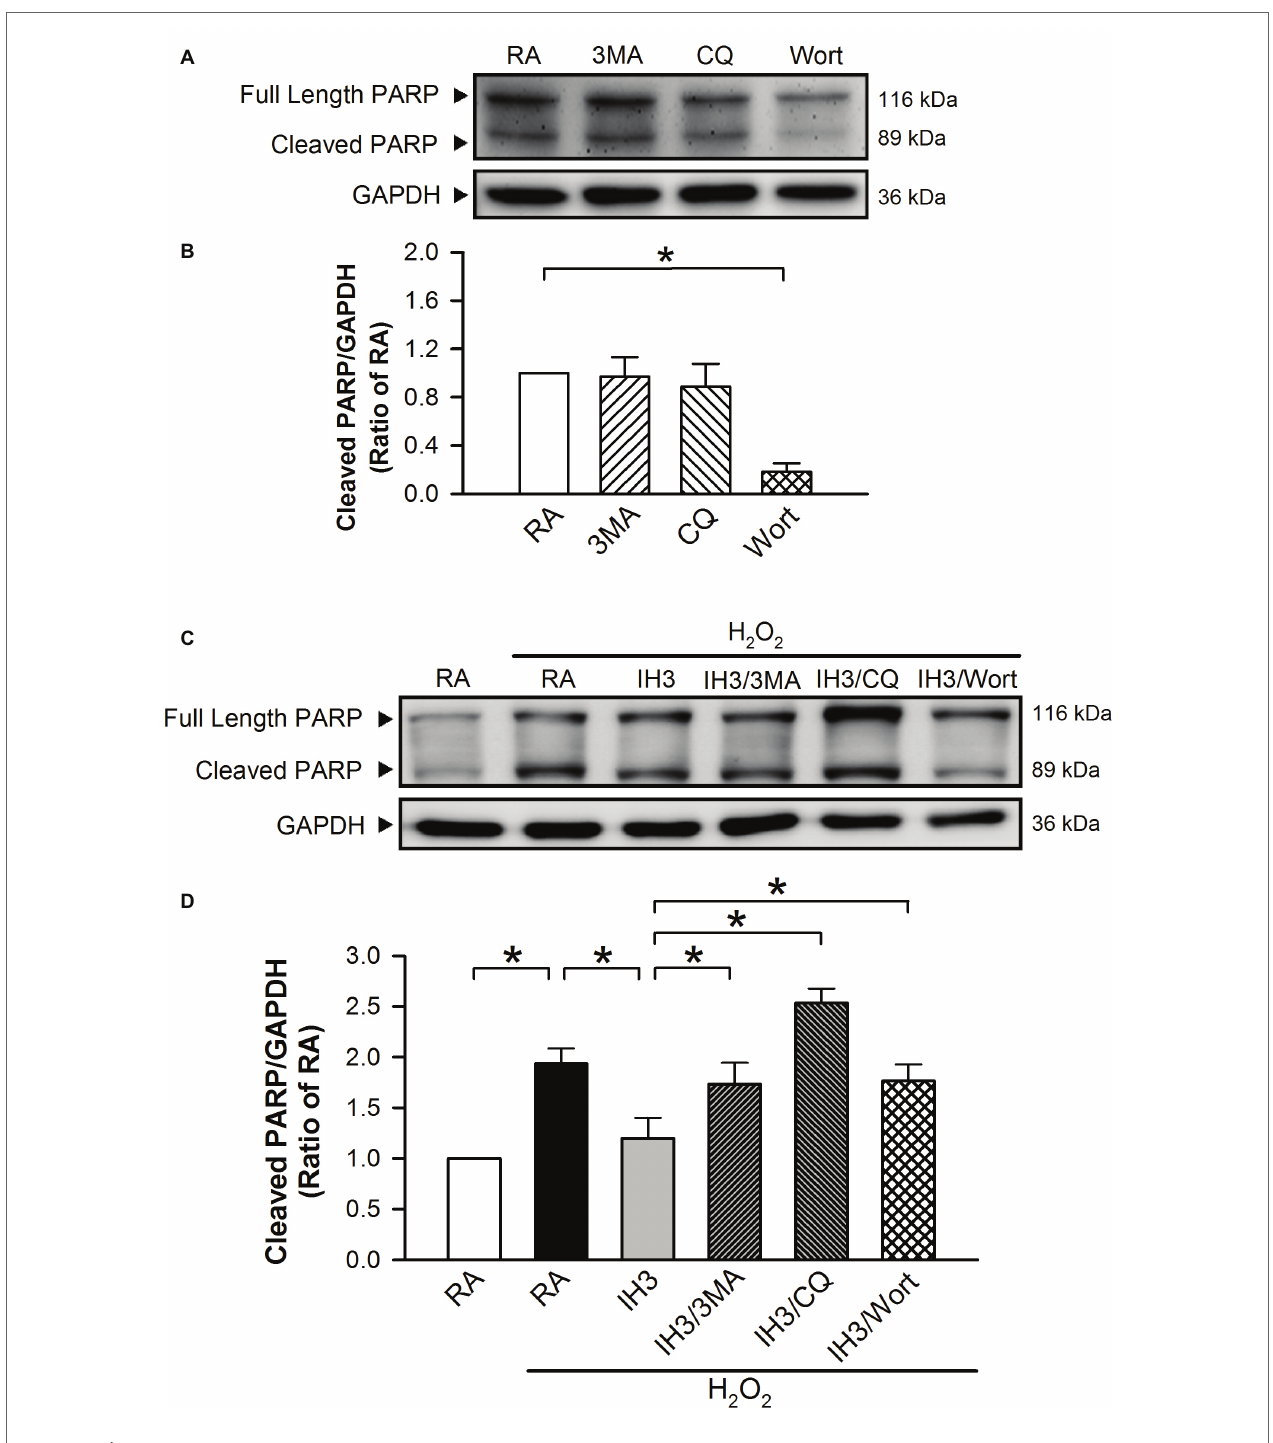
FIGURE 6 | Involvement of autophagy in the IH-attenuated ER stress-induced cell death in H9c2 cells. Cells were treated with RA, RA combined with 3MA, RA combined with CQ, or RA combined with Wort. (A) A representative result of full length PARP, cleaved PARP, and GAPDH protein levels determined by Western blot analyses. Quantitative results of cleaved PARP protein levels were adjusted with GAPDH protein level and expressed as ratio over the RA group. ( n = 4). (B) Cells were treated with RA or IH for 3 days followed by H 2 O 2 , H 2 O 2 combined with 3-methyladenine (50 μM), H 2 O 2 combined with chloroquine (5 μM), or H 2 O 2 combined with wortmannin (5 nM) for additional 24 h, and then harvested for detecting the cleaved PARP and GAPDH protein levels. (C) A representative result of full length cleaved PARP, cleaved PARP, and GAPDH protein levels determined by Western blot analyses. (D) Quantitative results of cleaved PARP protein levels were adjusted with GAPDH protein level and expressed as ratio over the RA group. Values are means ± SEMs. ( n = 3). * p < 0.05. 3MA, 3-methyladenine; CQ, chloroquine; IH, intermittent hypoxia; RA, room air; Wort,